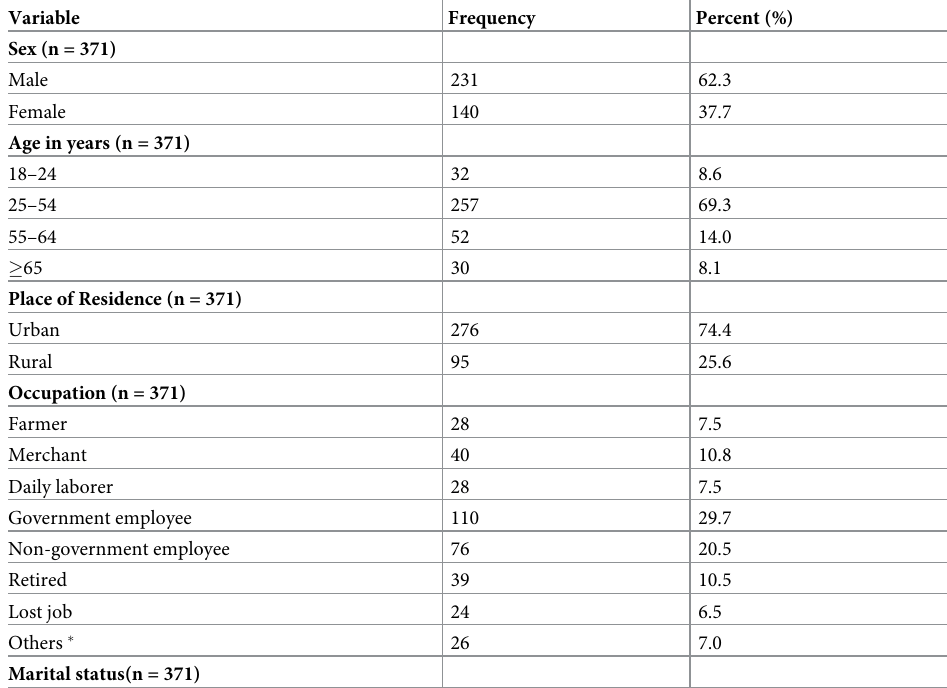
Table 1. Socio demographic characteristics of chronic kidney disease patients in Saint Paulo’s and Zewditu Memorial Hospitals in Addis Ababa, Ethiopia, 2018.